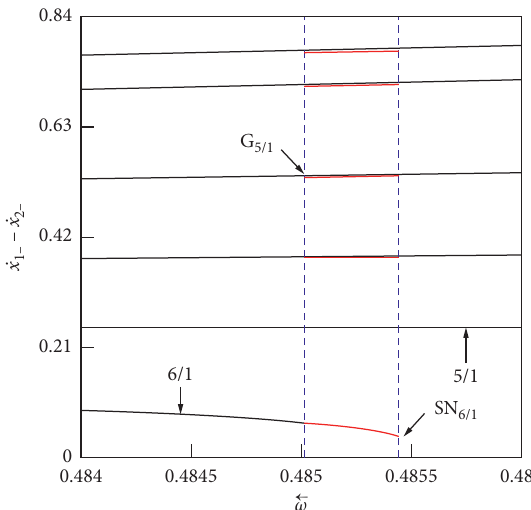
Figure 15: Bifurcation diagrams that cross the hysteresis region HR